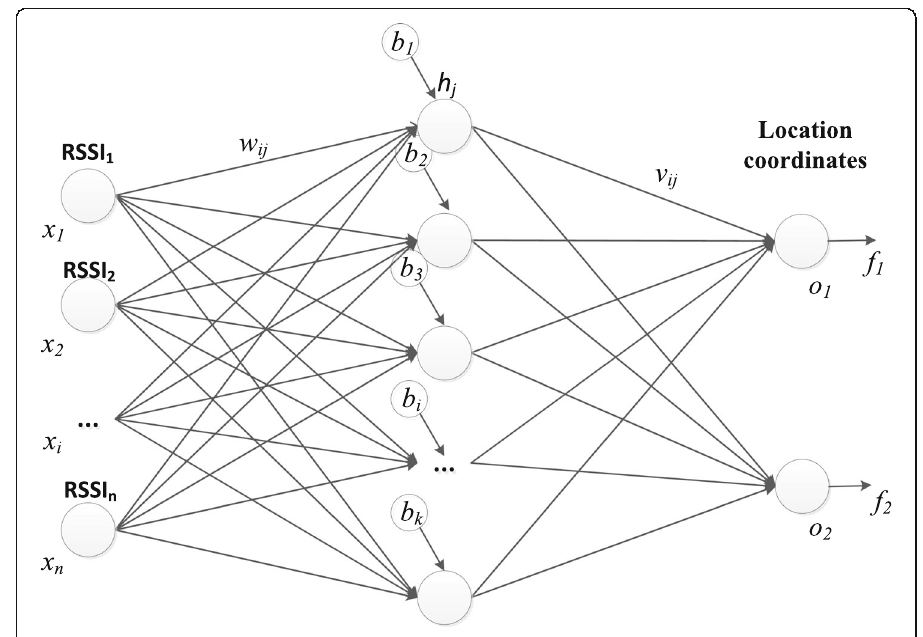
Fig. 3 Structure of location determination